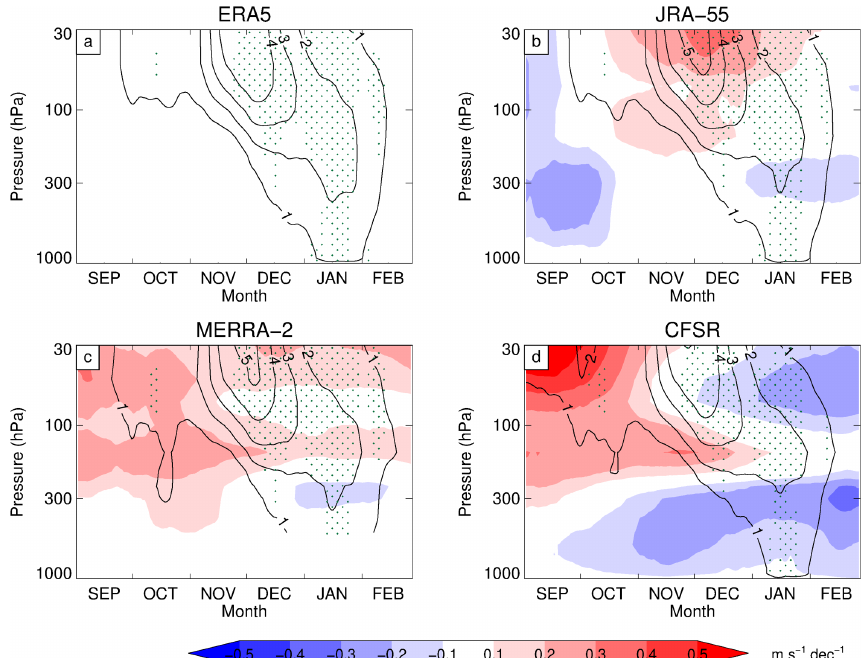
Figure 2. Time–height cross section of the trend in the zonally averaged zonal wind (contour intervals: 1, 2, 3, 4, and 5ms − 1 per decade) averaged over 50 to 70 ◦ S from 1980 to 2001 for ERA5 (a) , JRA-55 (b) , MERRA-2 (c) , and CFSR (d) . The shading represents differences from ERA5 at intervals of ± 0.1, ± 0.2, ± 0.3, ± 0.4, and ± 0.5ms − 1 per decade. Results in the range 500 to 1000hPa are not included in panel (c) . Stippling denotes regions where the trends are significant at the 5% significance level. Note that for each panel the time series is smoothed.